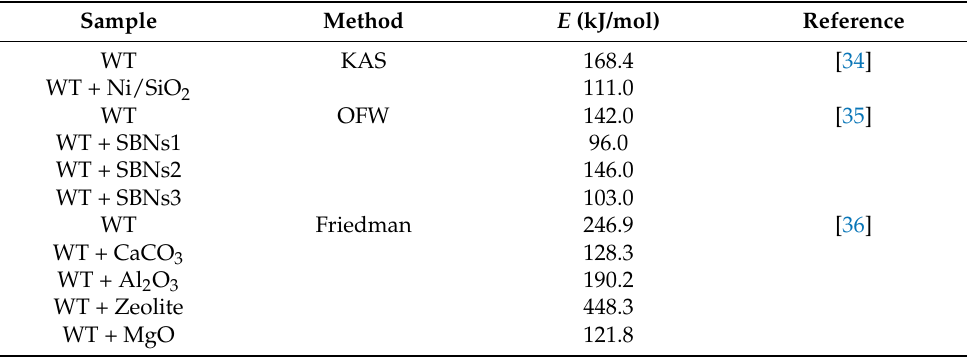
Table 4. Summary of waste tire catalytic pyrolysis kinetic